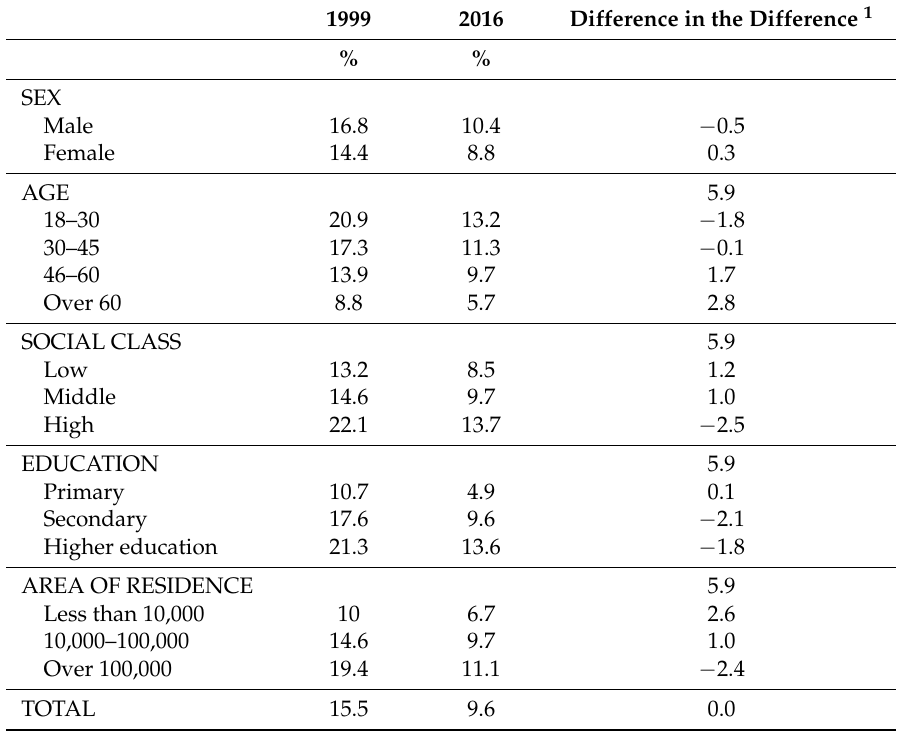
Table 3. Comparison of the sociodemographic profiles of people who have experienced a crime in the last 12 months in Spain (1999 and